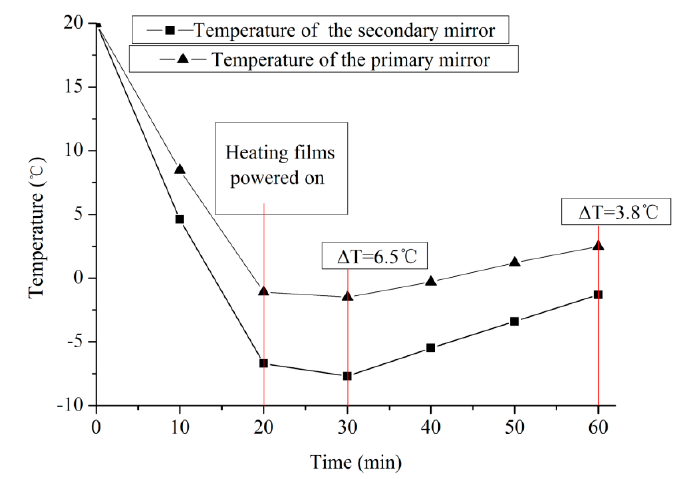
Figure 8. Temperature changes of the primary mirror and the secondary mirror during the test.